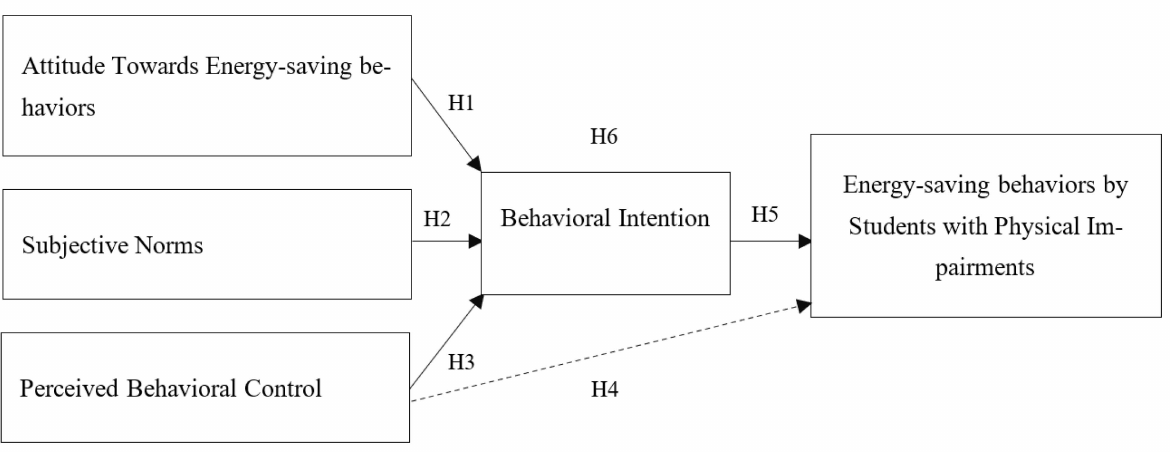
Figure 1. Theoretical